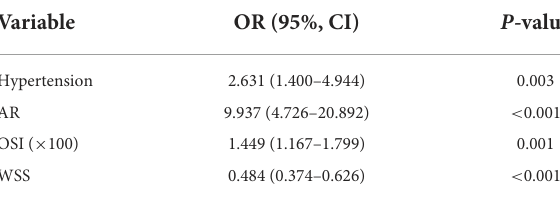
TABLE 3 Multivariable logistic regression analysis for the selected variables by